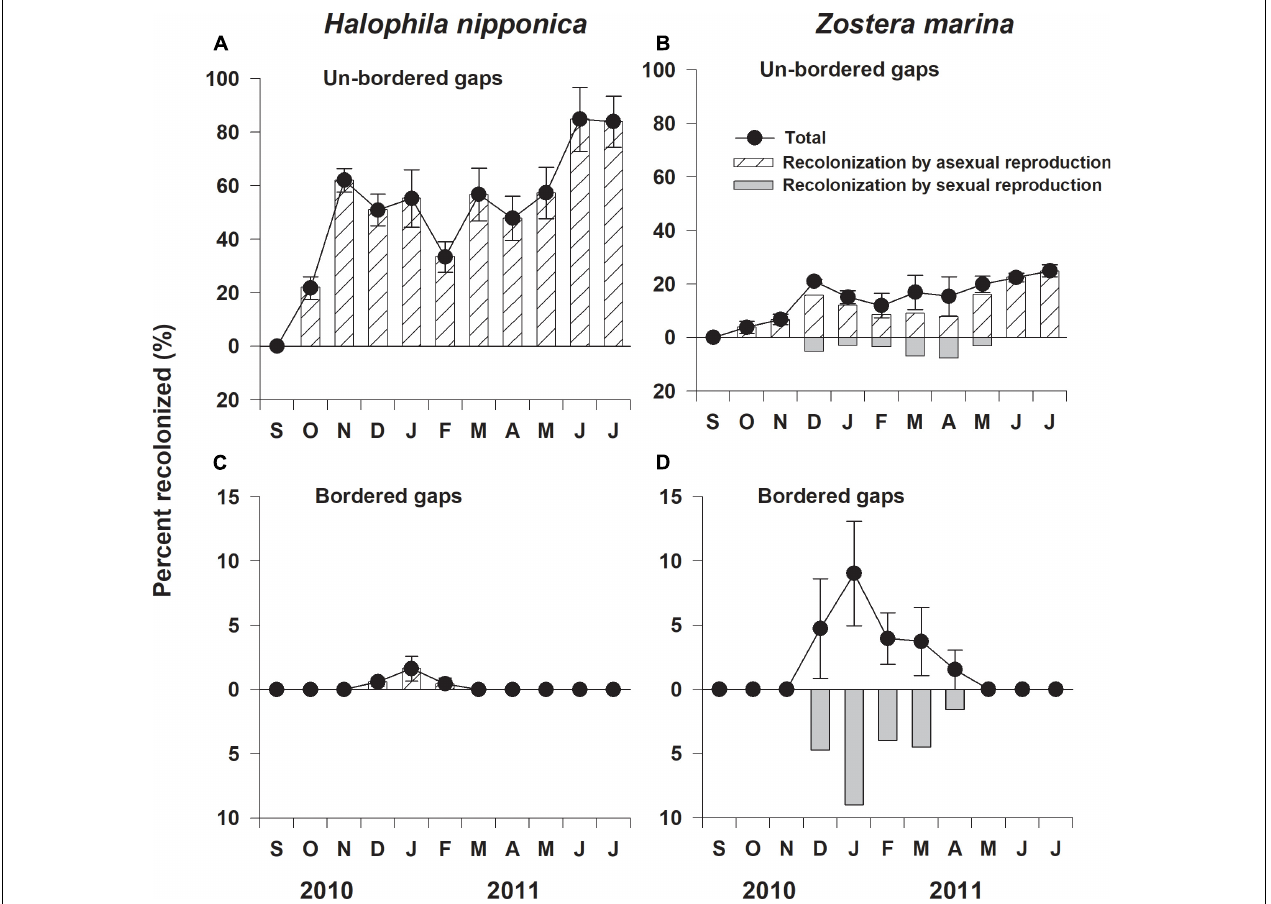
FIGURE 3 | Percent recolonized and relative contribution of sexual and asexual reproduction to recolonization of Halophila nipponica and Zostera marina at the un-bordered (A,B) and bordered (C,D) gaps at the study site from September 2010 to July 2011.